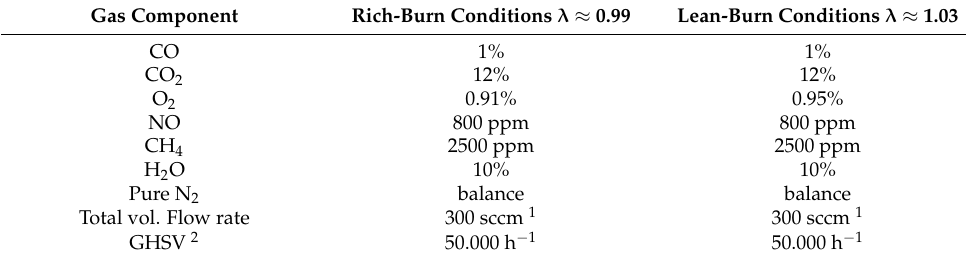
Table 2. Selected gas mixtures concentrations for λ ≈ 0.99 and λ ≈ 1.03. Gas Component Rich-Burn Conditions λ ≈ 0.99